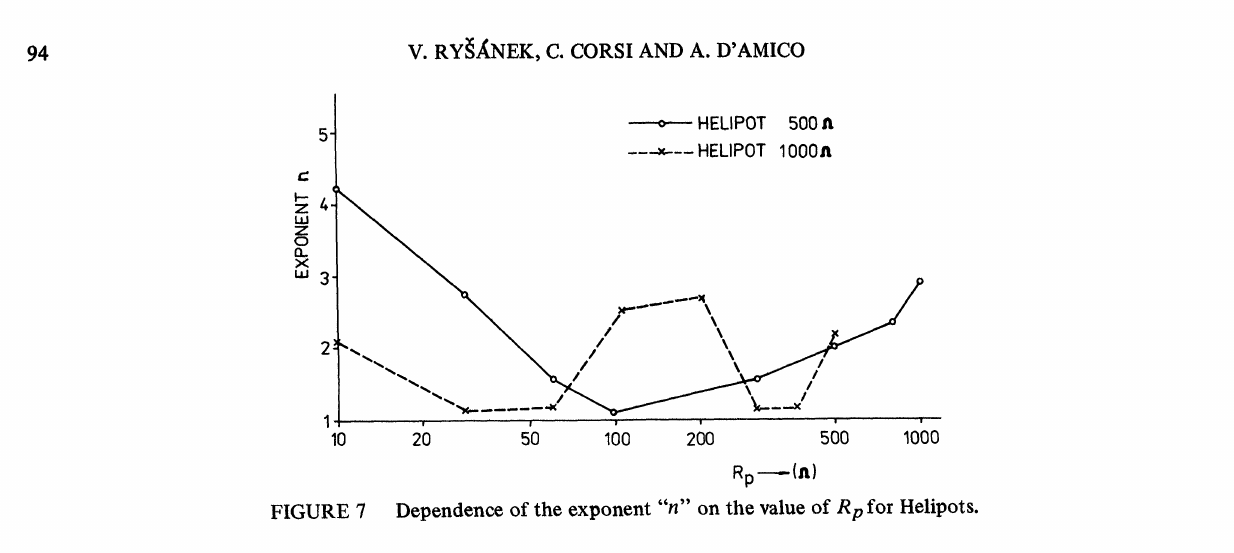
Dependence of the exponent "n" on the value of Rp for Helipots.